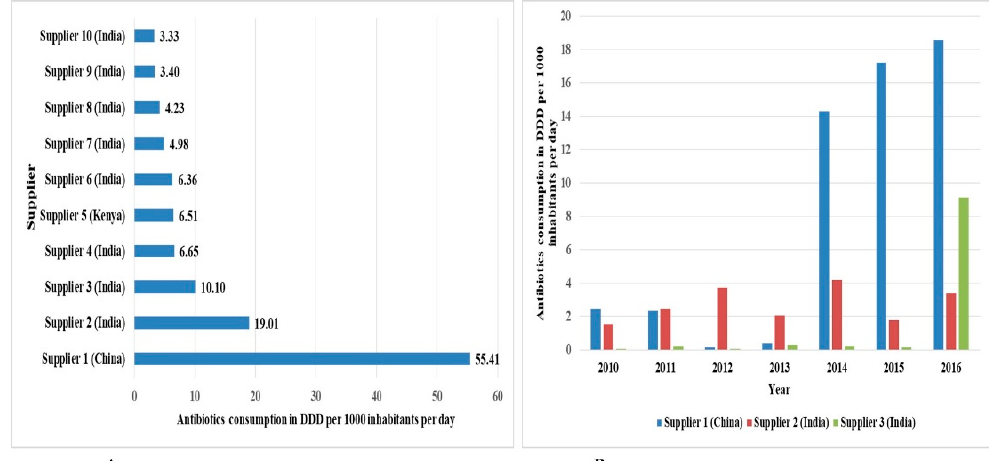
Figure 6. Top (local) importers of antibiotics utilized in Tanzania between 2010 and 2016. Panel ( A ) shows the top 10 importers, and panel ( B ) shows the annual distribution of the top 3 importers. The top supplier of antibiotics in the study period was from China, and eight of the top ten suppliers were from India and Kenya.